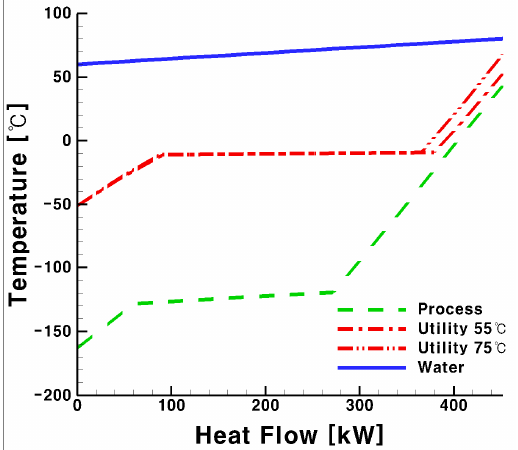
Figure 8. Heat transfer performance as a function of temperature in each group when using CO 2 as a heat medium.